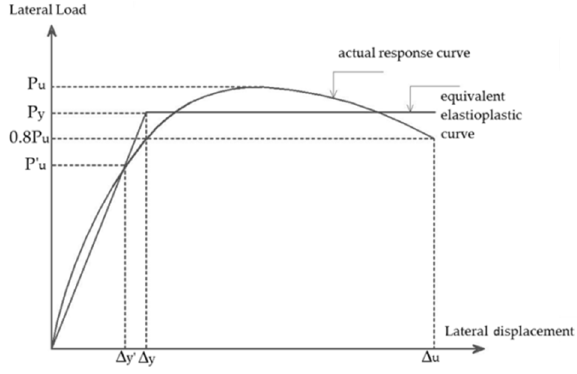
Figure 9. Elasto ‐ plastic idealization. Figure 9. Elasto-plastic